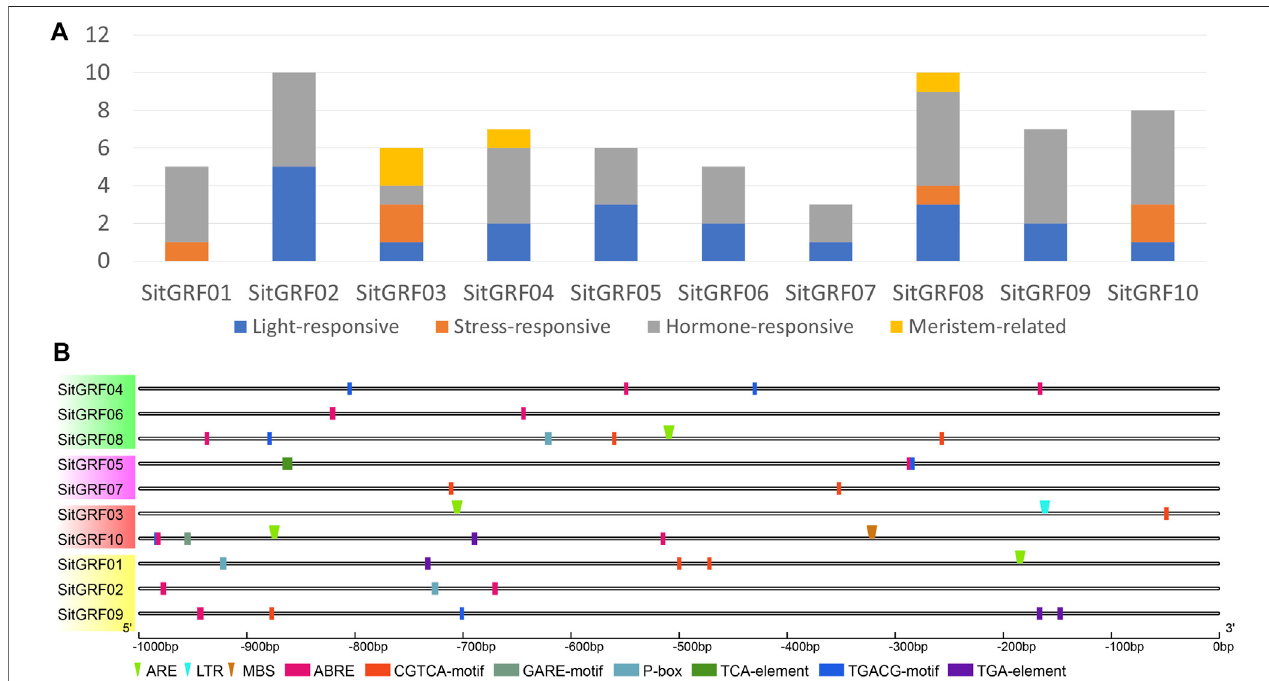
FIGURE8| Promoteranalysisoffoxtailmillet GRF genes. (A) Distributionoffourkindsof cis -regulatoryelementsinthepromoteroffoxtailmillet GRF genes. (B) The 1 Kb promoter sequences of corresponding GRF genes were used to analyze hormone-related cis -elements and stress-related elements. Rectangle indicates stress- related elements, and the inverted triangle indicates hormone-related elements. Different cis -elements were indicated by different colored symbols and placed in their relative position on the promoter.